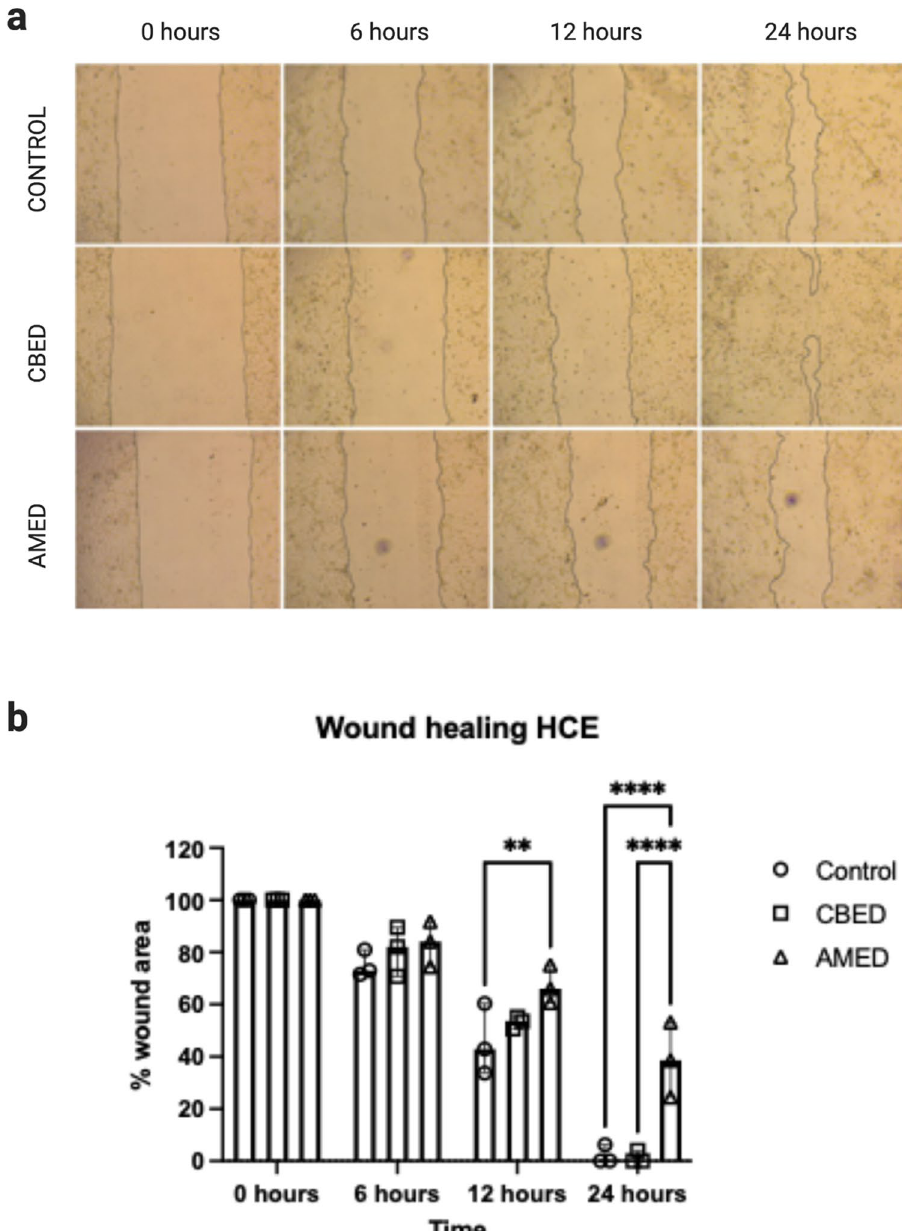
CBED, AMED or control (FBS), was used at 10% concentration in complete medium. The images represent one of the replicates and area measured as wound. ( b ) Area closure in wound healing experiments (scratch test) was represented as percentage closure (%). Image J was used to calculate closure area. Bars show the median and range (n = 3). There are no statistically significant differences between CBED and control at any time point, however closure is significantly lower in AMED compared to control at 12- and 24-h time points ( p = 0.0042 and p < 0.0001 respectively) and at 24 h also significantly lower than CBED ( p < 0.0001) (2-way ANOVA with Tukey’s post-hoc test used) p < 0.01 ( ** ); p < 0.001 ( *** ), p < 0.0001 ( **** ). (Figure created with